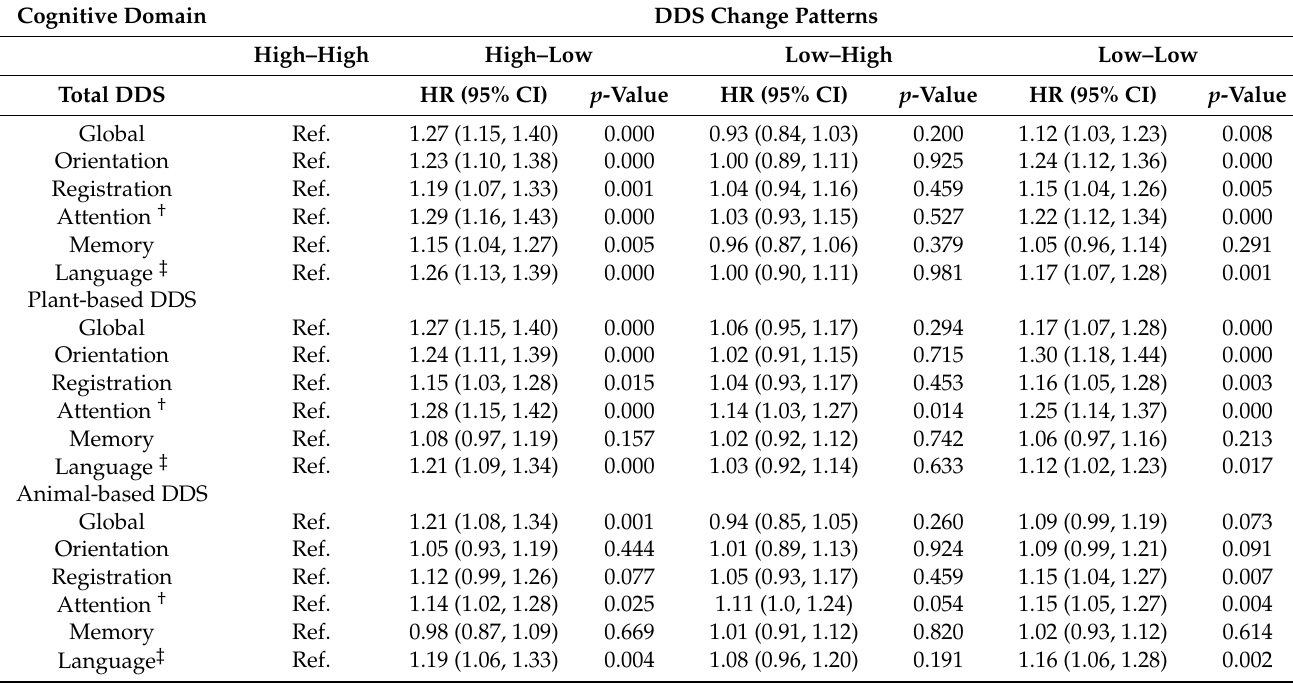
Table 4. HRs (95% CIs) of incident decline in different cognitive domains with the DDS change patterns.